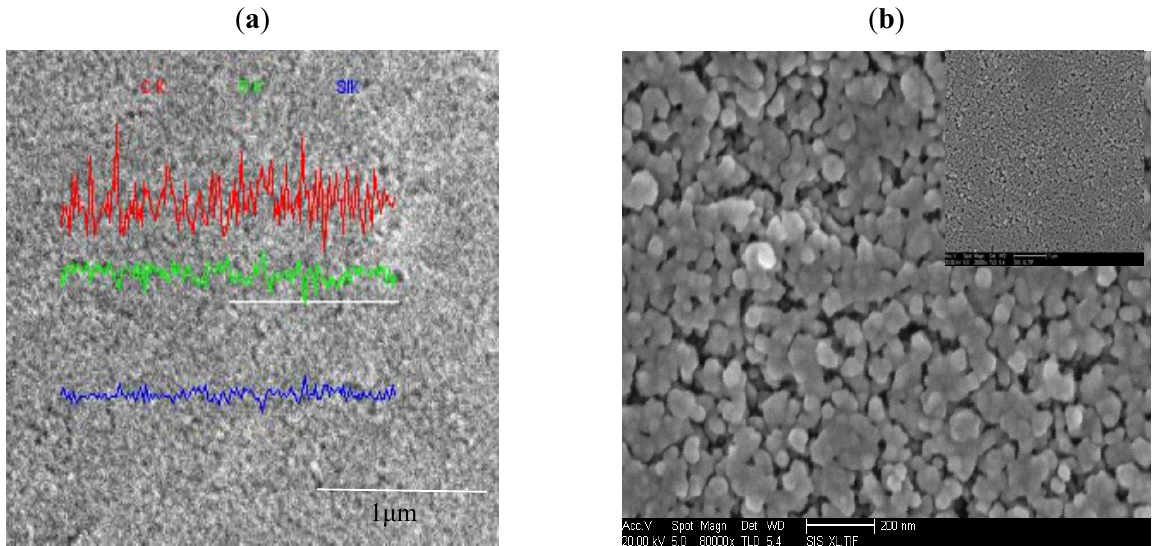
Figure 3. Surface of recording coating on inkjet printing (RC-IJP): ( a ) Morphologies of SEM; and ( b ) Distribution of C, O and Si composites by